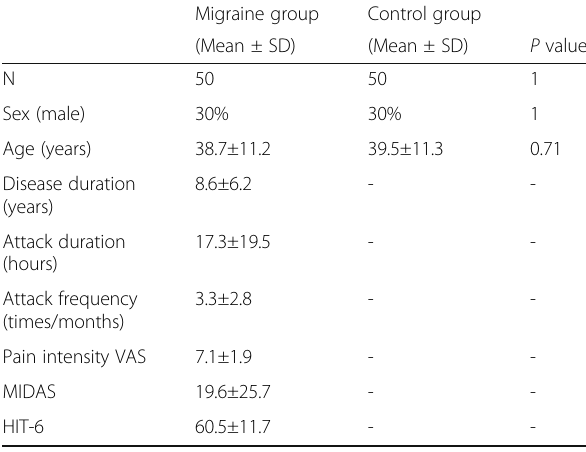
Table 1 Demographic data and clinical scores of the migraine and control